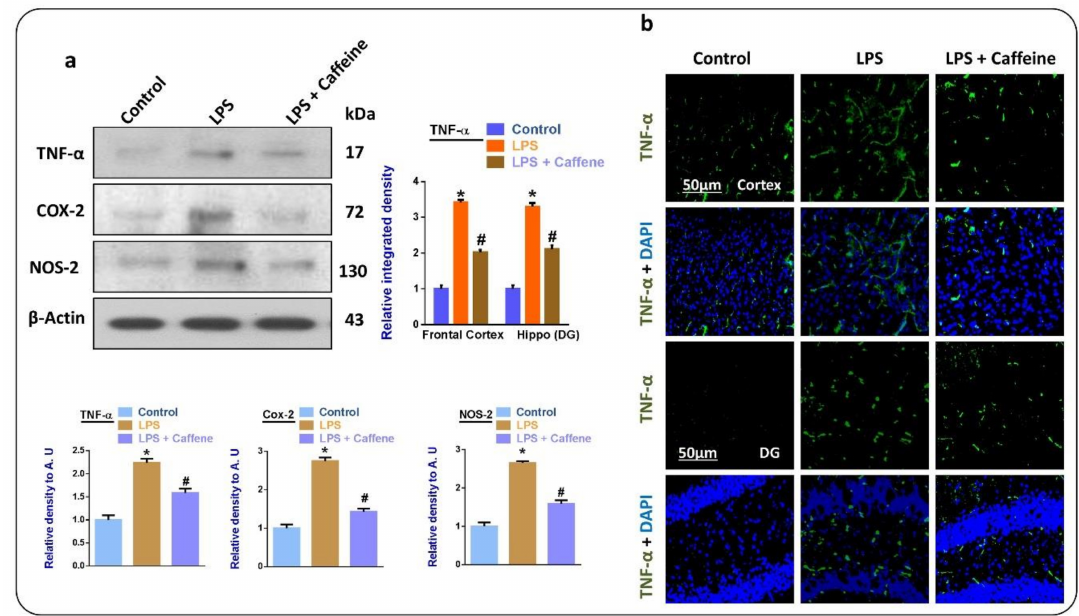
Figure 3. Ca ff eine inhibits the release of inflammatory cytokines in LPS-injected mice: ( a ) Western blot results of tissue necrosis factor α (TNF- α ), nitric oxide Synthase 2 (NOS-2), and cyclooxygenase 2 (Cox-2) in the brains of the experimental mice ( n = 10 mice per group; number of experiments = 3; statistical analysis used was one-way ANOVA with Tukey’s posthoc test for comparisons among the di ff erent groups); ( b ) immunofluorescence images of TNF- α in the experimental groups, magnification 30 × , scale bar 50 µ m; * significantly di ff erent from the vehicle-treated control group, # significantly di ff erent from the LPS-treated mice group. Significance: * p < 0.05; # p < 0.05. DAPI: 4 (cid:48) , 6-diamidino-2-phenylindole. DG: Dentate